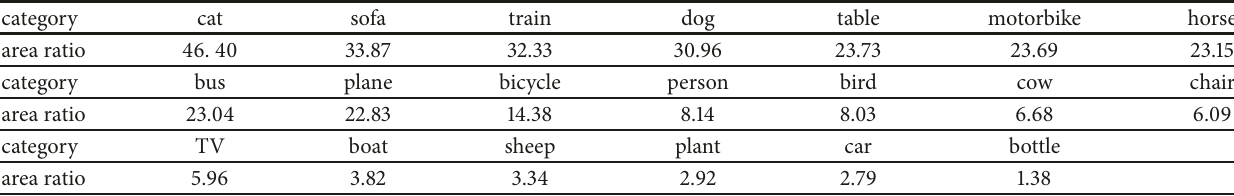
Table 2: PASCAL VOC object area account table. Unit: %.